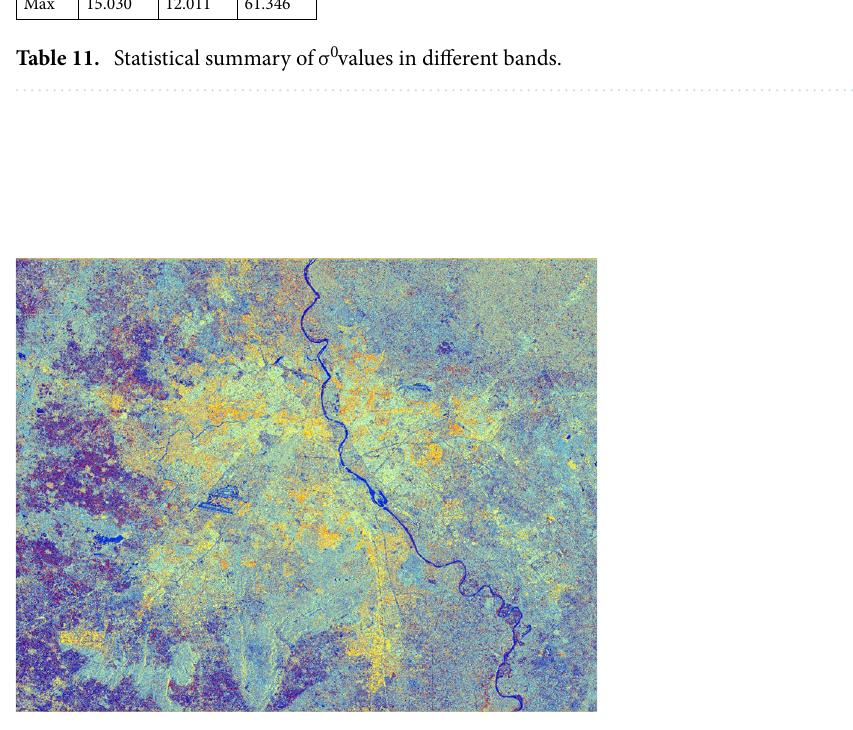
Figure 22. Dual-pol Sigma0 dB VV+VH Colour composite image (Red: VV, Green: VH, Blue: VH/VV) C-band Sentinel-1